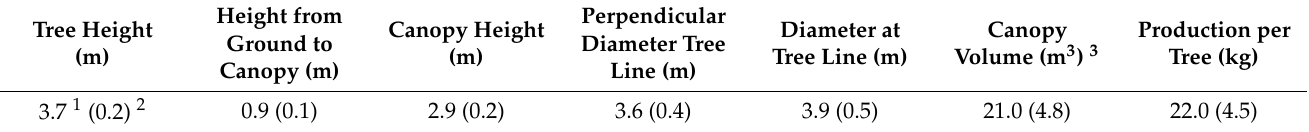
Table 1. Characterisation of the trees on the trial plot ( n = 12).